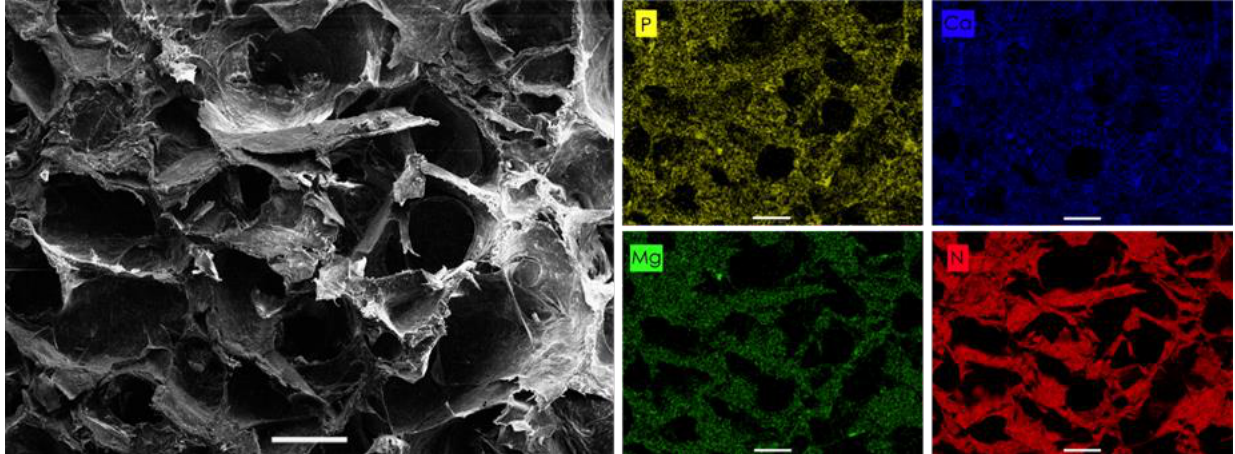
Figure 2. Energy dispersive X-ray spectroscopy (EDS) elemental maps of an area of RCP.MgAp scaffold showing the presence of P (yellow), Ca (blue) and Mg (green) of the mineral phase closely related to the N signal of the collagen (red). SEM image of the scaffold on the left displays the area of the mapping. Scale bar = 100 μm.